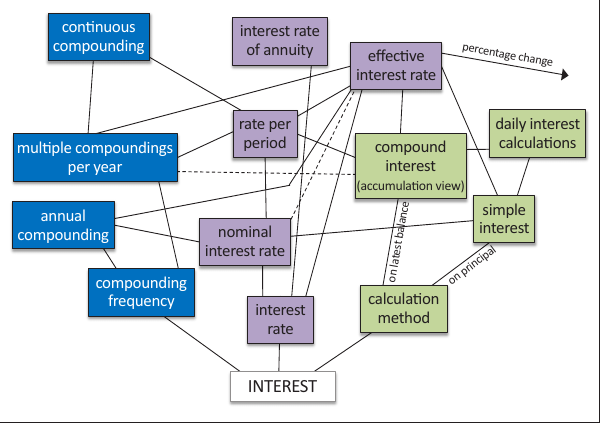
FIGURE 2: A network of concepts relating to growth